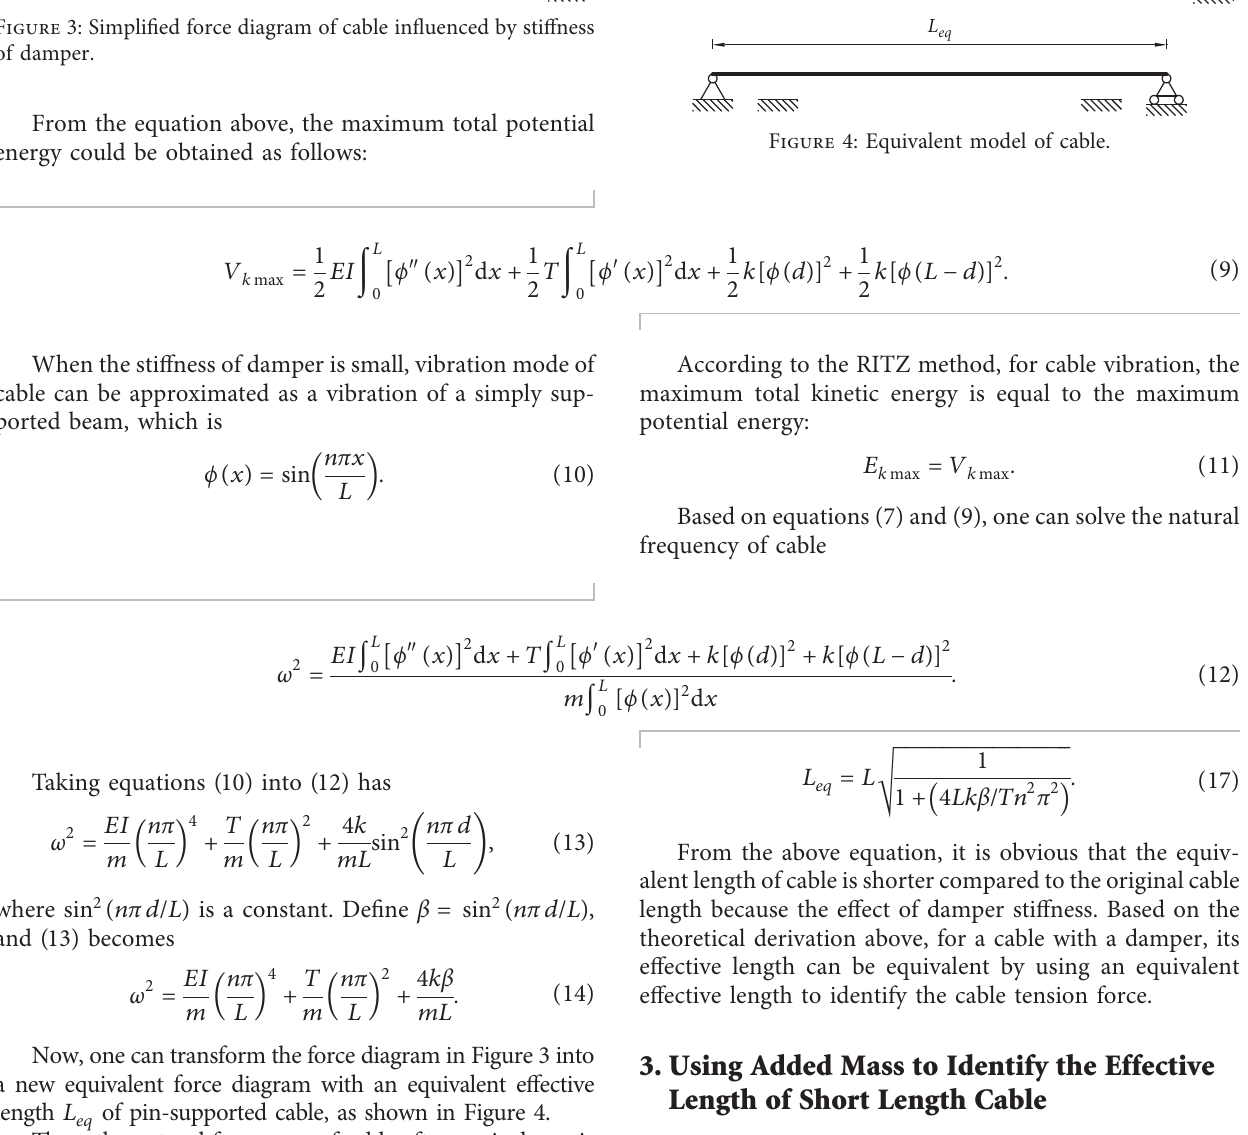
Figure 4: Equivalent model of